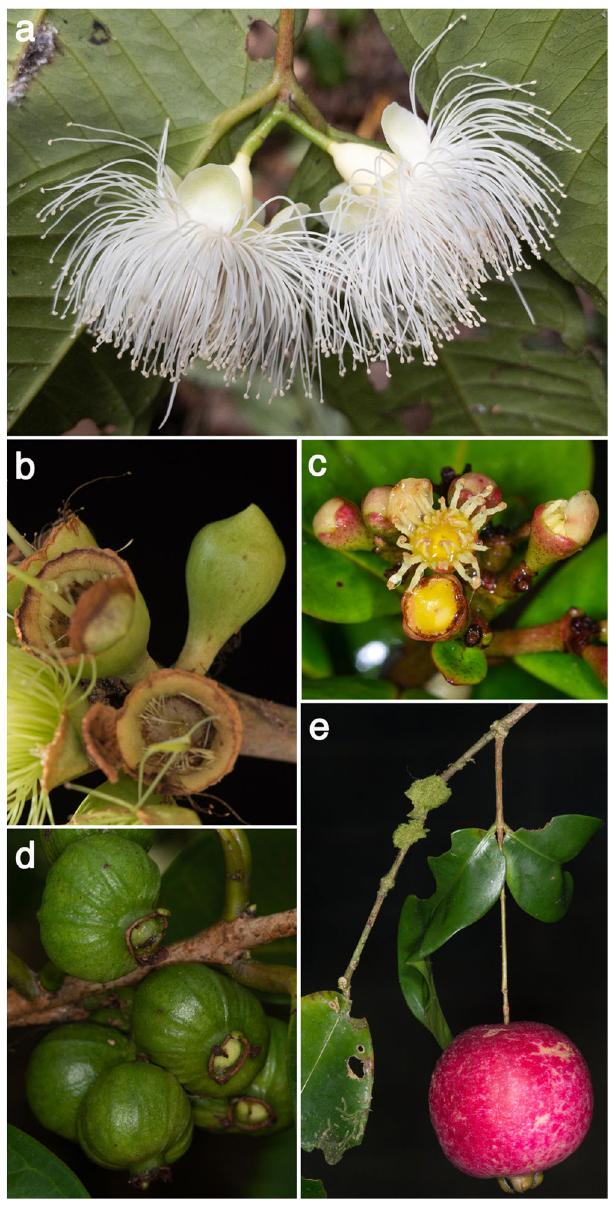
Fig. 5 | Reproductive trait diversity in the genus Syzygium , as examined to reconstruct ancestral states using Mesquite. a Free petals ( Syzygium pendens ); b Calyptrate calyx ( Syzygium paradoxum ); c Pseudocalyptrate corolla ( Syzygium adelphicum ); d Fruits maturing green ( Syzygium cf. dyerianum ); e Pendulous in fl or- escence or infructescence ( Syzygium boonjee ). Photograph credits: YWL ( a ) – ( e